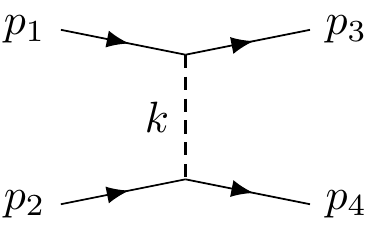
Figure 1 . The Feynman diagram of the pp scattering by the exchange of a glueball in the t-channel. p 1 and p 2 are the four-momenta of the incoming protons, and p 3 and p 4 are four-momenta of the outgoing protons. k is the four-momentum of the exchanged